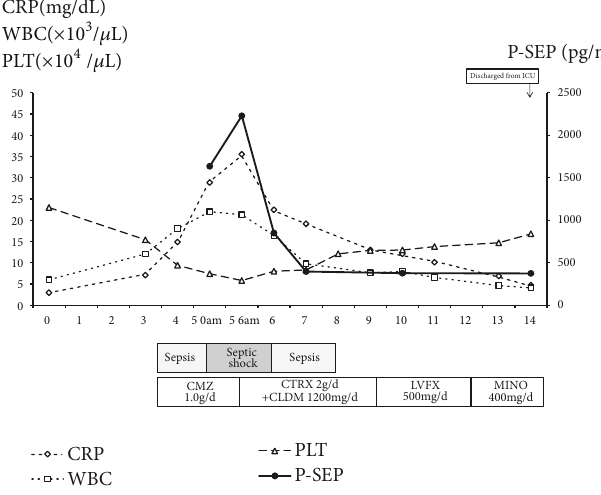
Figure 2: Time course of changes in P-SEP, WBC, CPR, and platelet count.